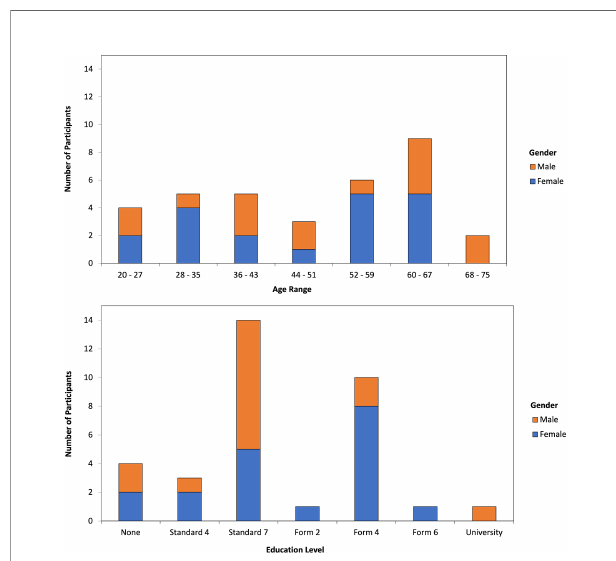
FIGURE 3 | Distribution of urban farmers ’ age (top) and education level (bottom) corresponding to their gender. Standard 7 (primary school) completion was reported by more males than females, but Form 4 (secondary school) completion was reported by more females than